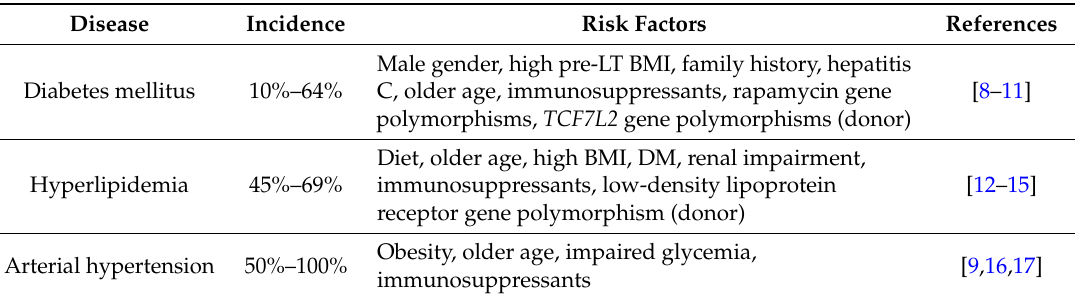
Table 1. Multifactorial conditions affecting transplant